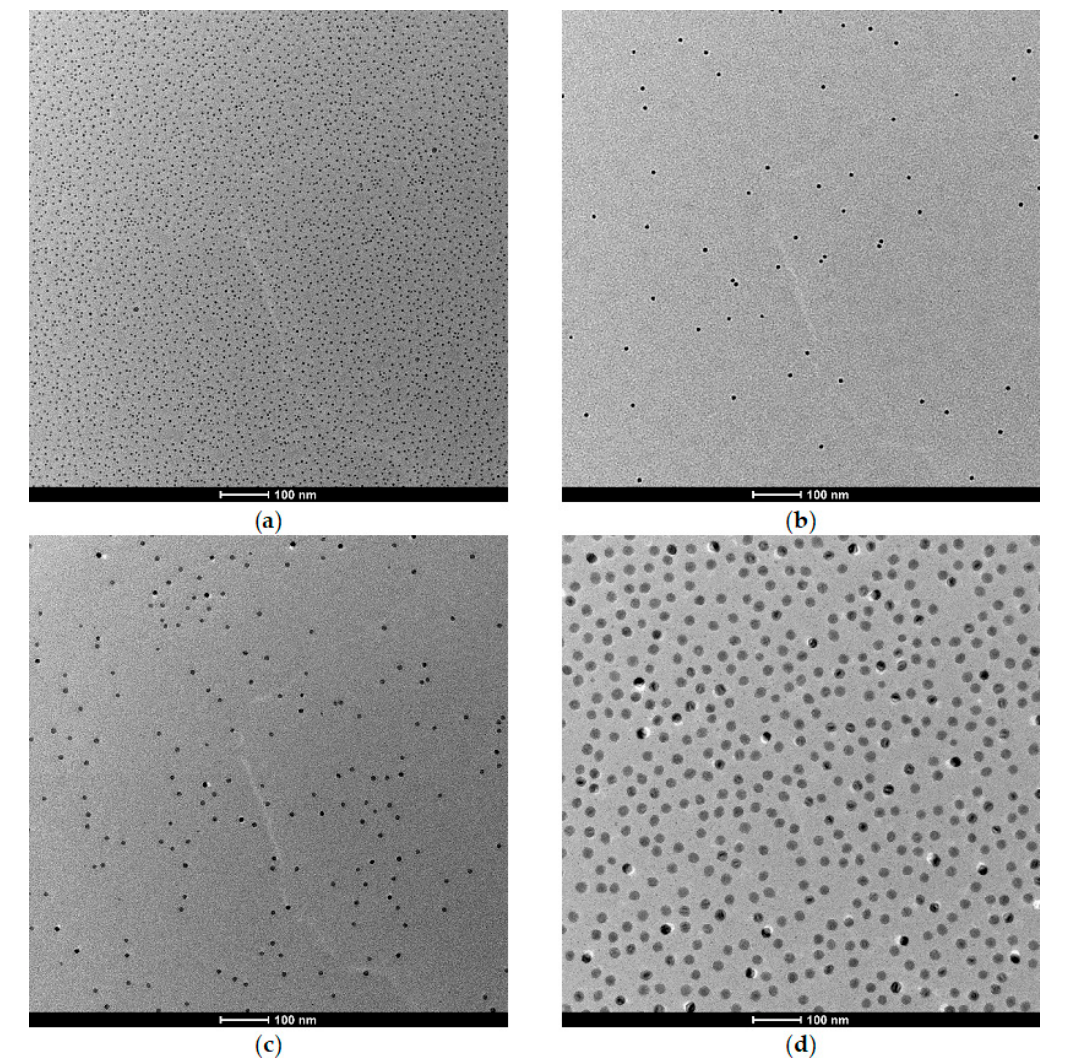
Figure 2. Transmission electron microscopy (TEM) micrographs of iron oxide nanoparticles grafted with poly(2-isopropyl-2-oxazoline) (26 kDa). The iron oxide core size was varied ( a ) 5.1 ± 0.6; ( b ) 7.4 ± 0.5 nm; ( c ) 10.2 ± 0.7 nm; ( d ) 20.9 ± 1.3 nm. Scale bar corresponds to 100 nm.